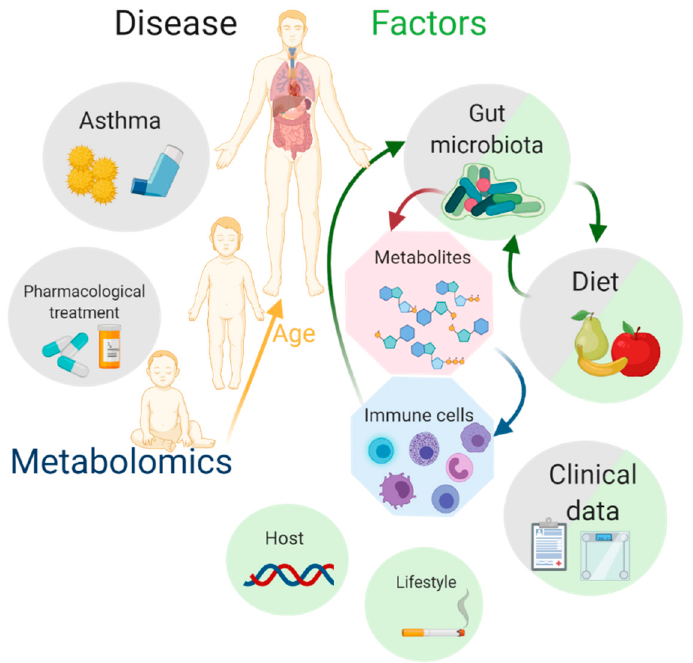
Figure 1. Metabolomics in the quest of asthma biomarkers. Some of the main factors that affect metabolites are diet, lifestyle, genetics, clinical parameters, and gut microbiota. There is a close relationship between intestinal microbiota, serum metabolites, and immune cells. All these factors are also connected with asthma, their pharmacology treatment, and age.